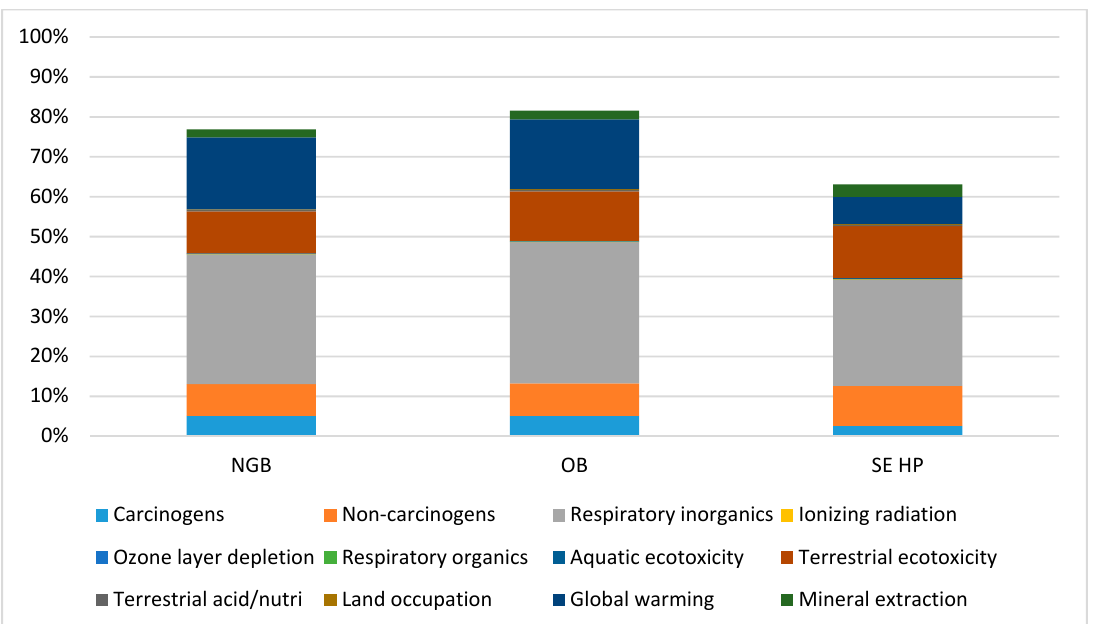
Figure 9. Comparison of damage assessment and characterization Stirling cycle-based HP (SE HP), oil boiler (OB), and natural gas boiler (NGB) on a relative scale for eight years of operation (excluding decommissioning).